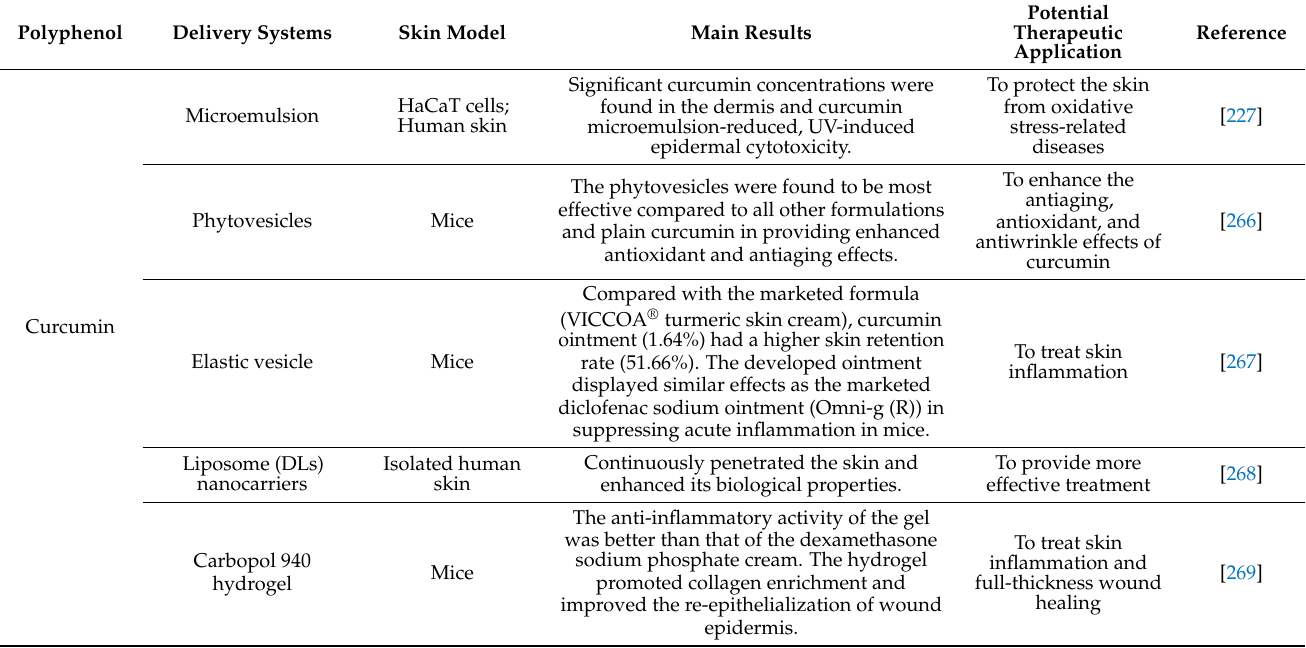
Table 3. Plant polyphenol delivery systems (example of